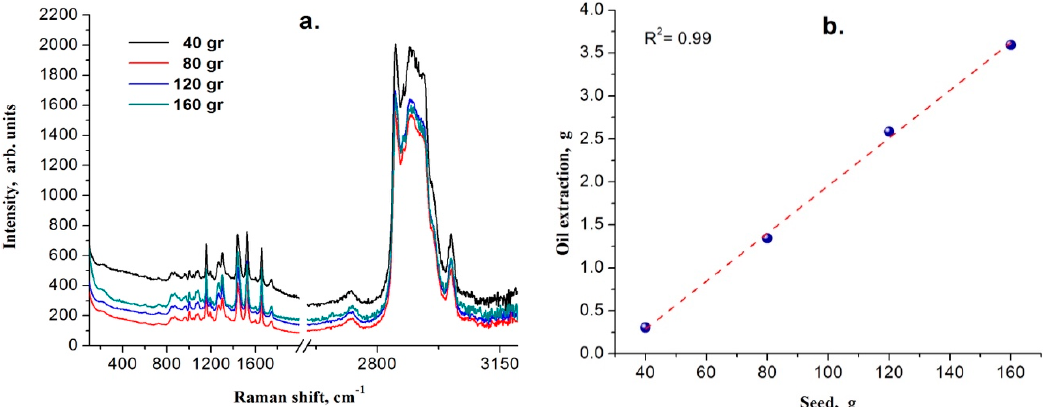
Figure 1. Raw Raman spectra recorded. ( a ) Average Raman spectra recorded for each batch of oil extracted with different amount of seed. ( b ) The weight ratio between the processed seed versus extracted oil shows a linear tendency.